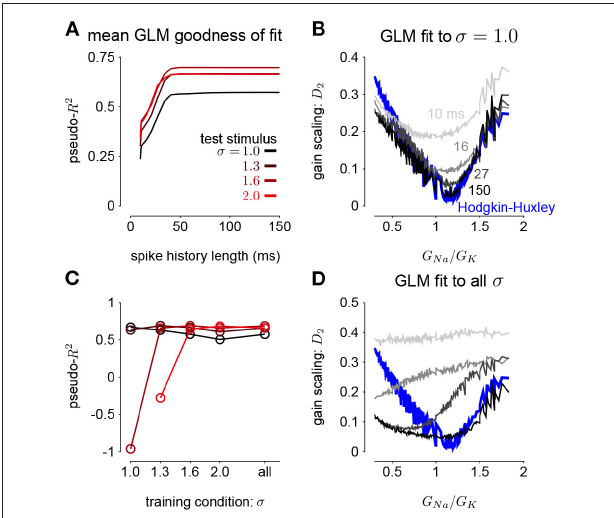
FIGURE 5 | (A) The pseudo- R 2 of the GLM fits at the four different stimulus SDs averaged over all G Na and G K as a function of spike history length. The GLMs were trained at all stimulus conditions. (B) Gain scaling in the Hodgkin-Huxley simulations (blue) measured as a function of the sodium-potassium conductance ratio ( G Na / G K ). The gray traces show gain scaling measured in the GLMs fit to the HH simulations for four different spike history filter length. The GLMs were trained using HH simulations with the stimulus at the baseline SD ( σ = 1.0). (C) The average pseudo- R 2 measured for each σ for the GLMs given each training stimulus condition. (D) Same as B for the GLMs fit only using all four values of σ